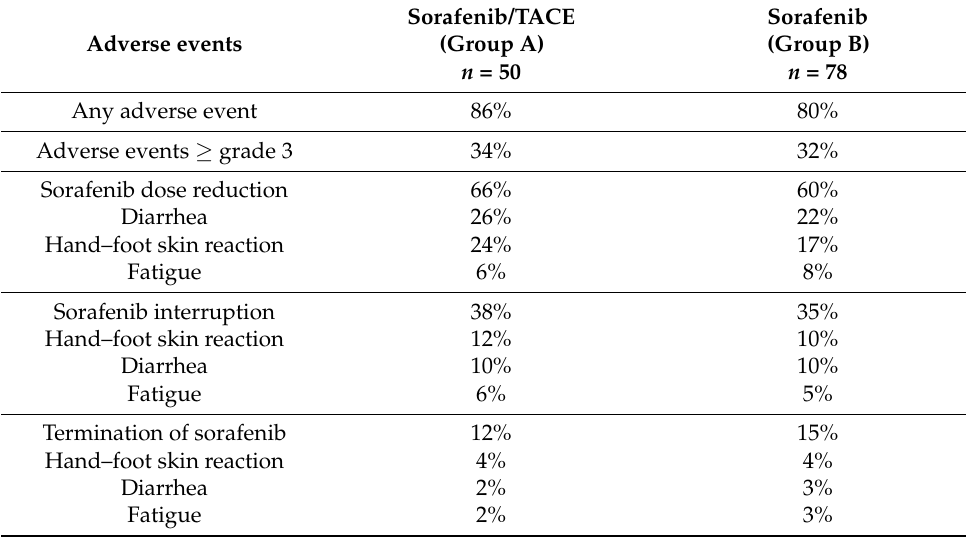
Table 5. Sorafenib-related adverse events.